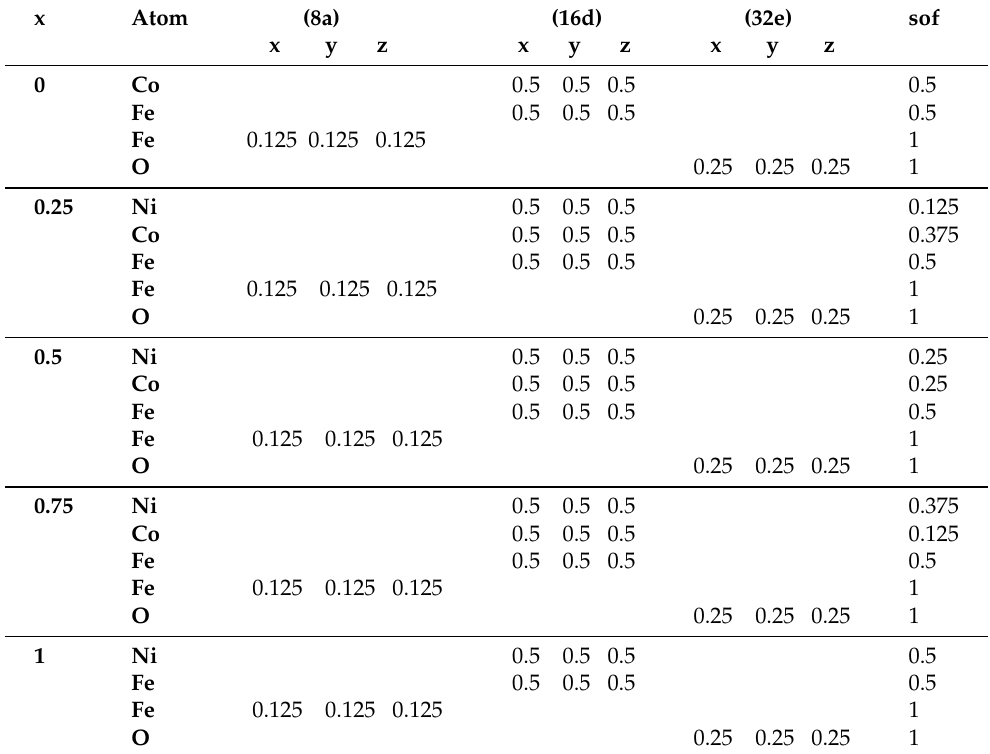
Table 1. Rietveld refinement input parameters for Ni x Co 1 − x Fe 2 O 4 ferrite nanoparticles with 0 ≤ x ≤ 1. The description of the parameters is given in the